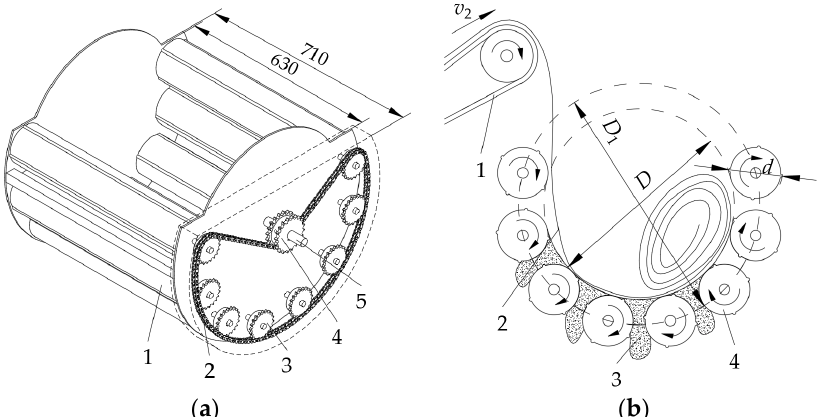
Figure 9. ( a ) The residual- fi lm collecting and bundling device: 1—plastic fi lm rolling roller; 2— drive chain; 3—roller sprocket; 4—input sprocket; 5—rotating shaft. ( b ) The operation principle of the residual- fi lm collecting and bundling device: 1—potato–plastic- fi lm separation device; 2— residual plastic fi lm; 3—debris; 4—plastic fi lm rolling roller.